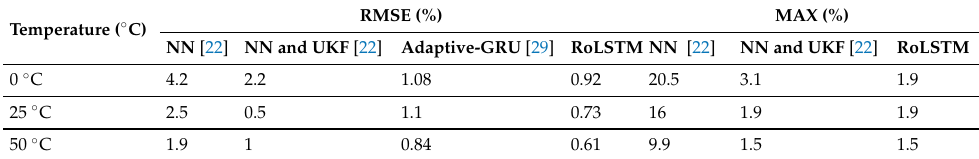
Table 4. Comparison of RMSE (%) and MAX (%) error of SOC estimation for A123 LifePO